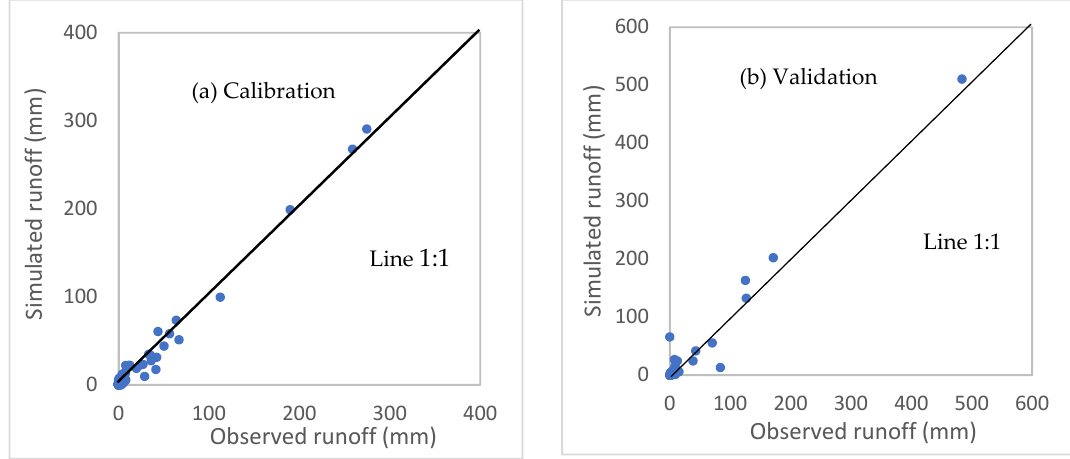
Figure 7. Scatter plot of the best input pattern (bold type in Table 6) of ANN models during the calibration ( a ) and validation ( b ) phases in the Calliope River catchment.